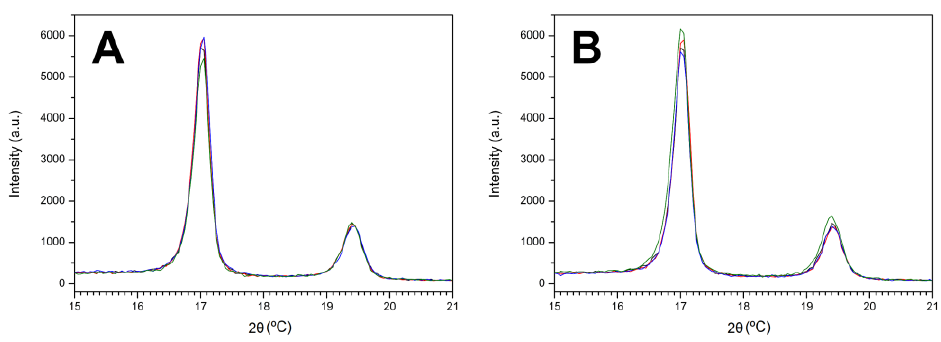
Figure 4. XRD diffractograms (a.u. = arbitrary units) within the 2θ range of ( A ) 15 – 25°, HDPE (black line), HDPE.Cl.0125 (red line), HDPE.Cl.0250 (blue line), and HDPE.Cl.0500 (green line) and ( B ) HDPE (black line), HDPE.MeS.0125 (red line), HDPE.MeS.0250 (blue line), and HDPE.MeS.0500 (green line).